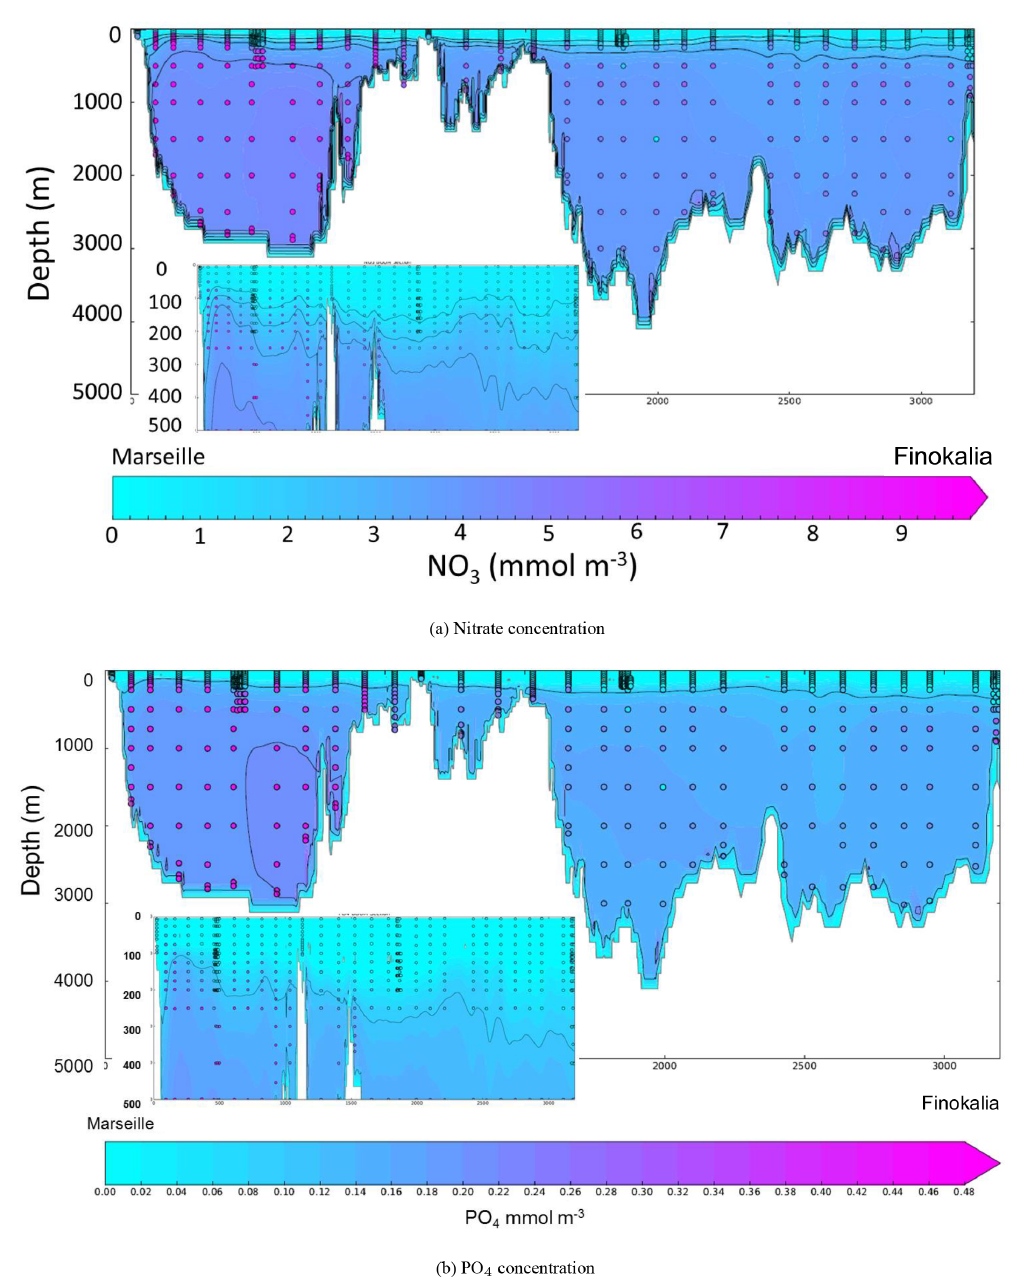
Figure A3. Average concentrations of nitrate (a) and phosphate (b) for the 20 first years of the control simulation (CTRL). The dots represent data along a transect from Marseille to Finokalia from the BOUM campaign (distances in km; Moutin et al., 2012). The framed areas represent a vertical zoom of the top 500 m along the whole